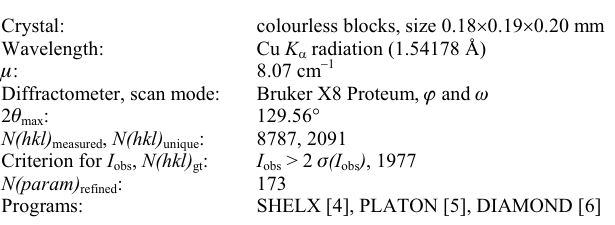
Table 1. Data collection and handling.